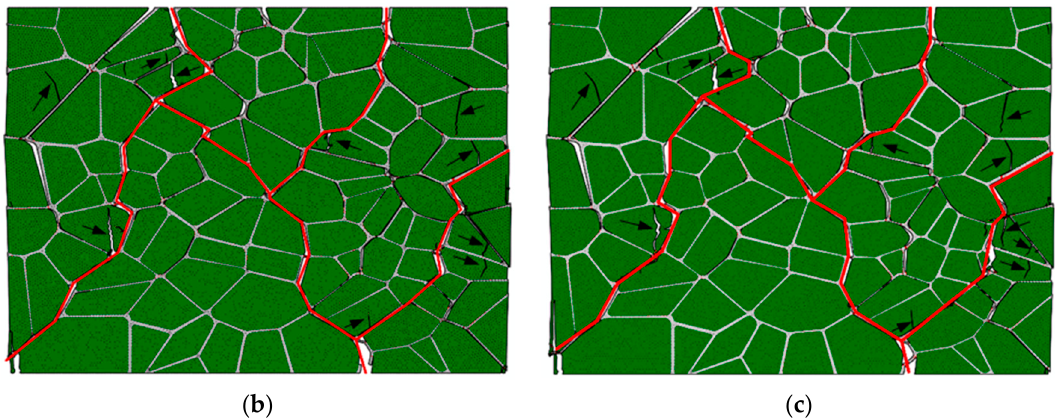
Figure 25. The failure path of PBX 9501 under compression loading at three strain rates: ( a ) 10 − 4 s − 1 , ( b ) 10 − 3 s − 1 , and ( c ) 10 − 2 s − 1 .